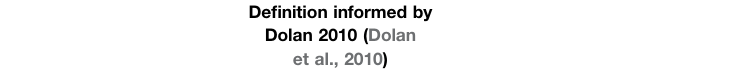
TABLE 1 | MINDSPACE contextual in fl uencers. Contextual In fl